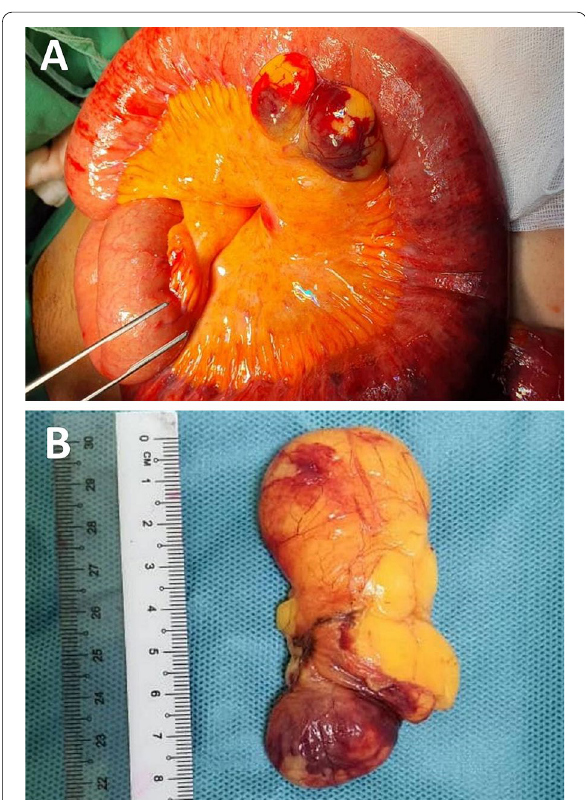
Fig. 3 A Intraoperative finding revealing a giant mesenteric lipoma (arrow) causing twisting of the small bowel that leads to the dusky appearance of the bowel. B An excised huge mesenteric lipoma that appears well-demarcated, partially encapsulated bright-yellow homogenous adipocytic